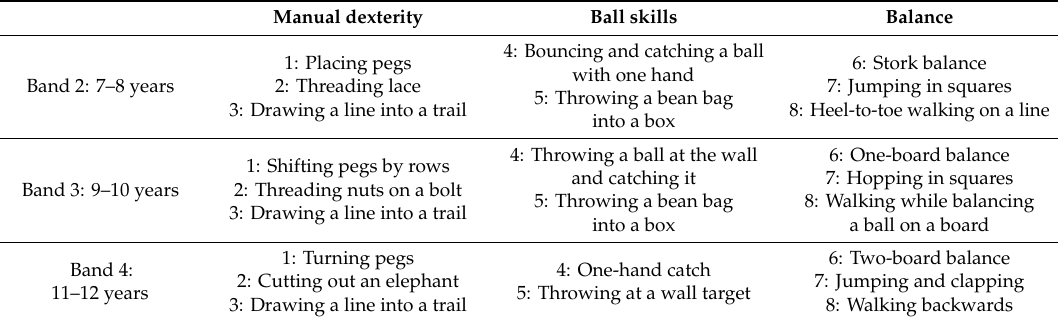
Table A1. Items of the Movement Assessment Battery for Children